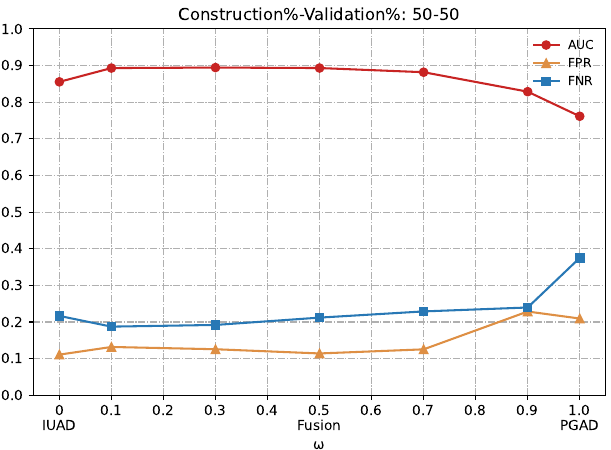
Figure 9. Detection results of the IUAD, the PGAD and the fusion model in terms of AUC, FPR, FNR